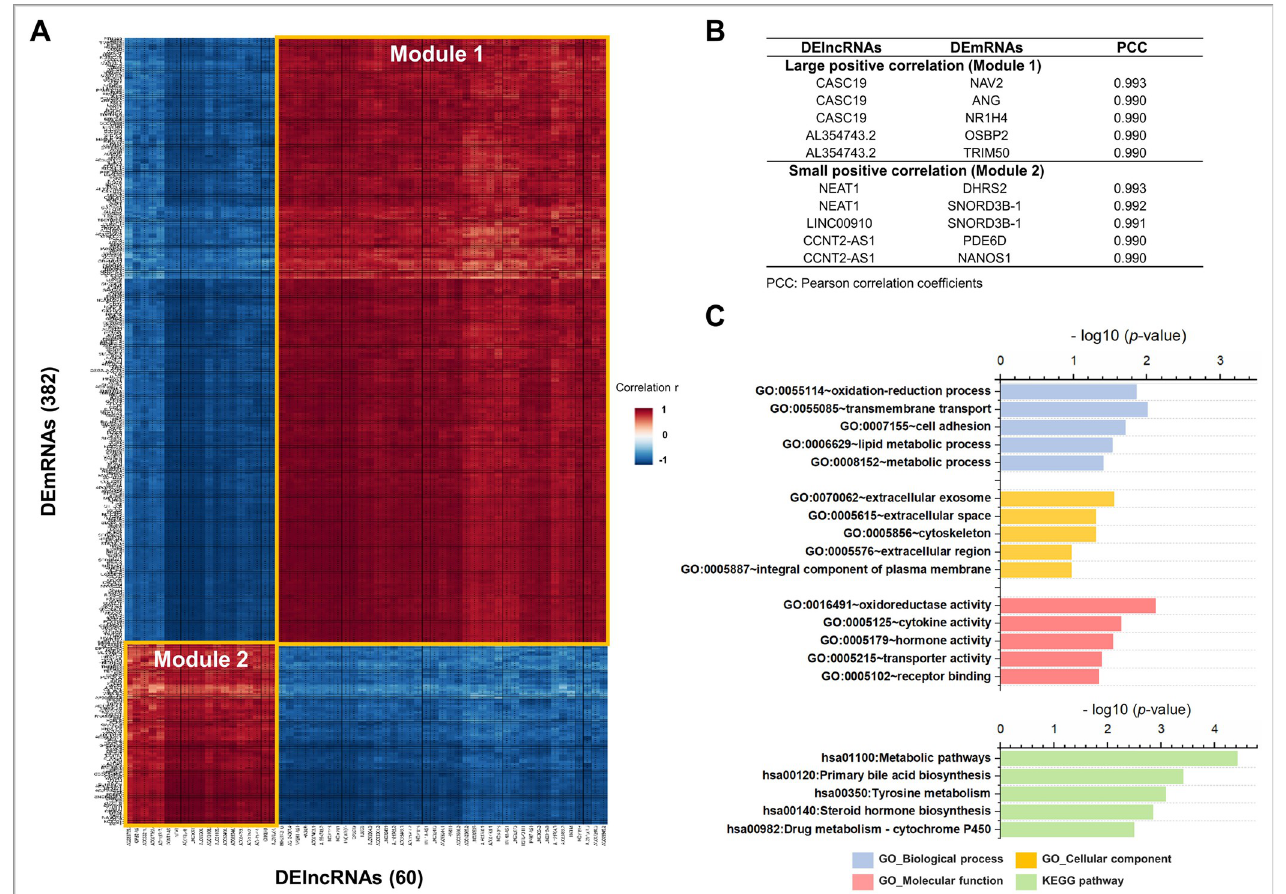
Fig 4. Correlation analysis and functional annotation of DEmRNAs in Module 1. (A) Correlation heat map of the DEmRNAs and DElncRNAs. The color scale shown in the heat map represents the correlation R values. Each row represents a DEmRNA, and each column represents a DElncRNA. Pearson correlation coefficients were calculated to determine the relationship of each lncRNA with individual mRNA. Red cells indicate a positive correlation, while blue cells indicate a negative correlation with a higher correlation indicated by higher color intensity as shown by the color scale. (B) Top 5 DElncRNA-DEmRNA pairs with correlation coefficients > 0.985 in HepG2 cells treated with JQ1, OTX015, and ABBV-075 in common. (C) The top 5 GO terms and KEGG pathways for DEmRNAs in Module 1 are shown. GO terms are divided into 3 categories (BP, CC, and MF).